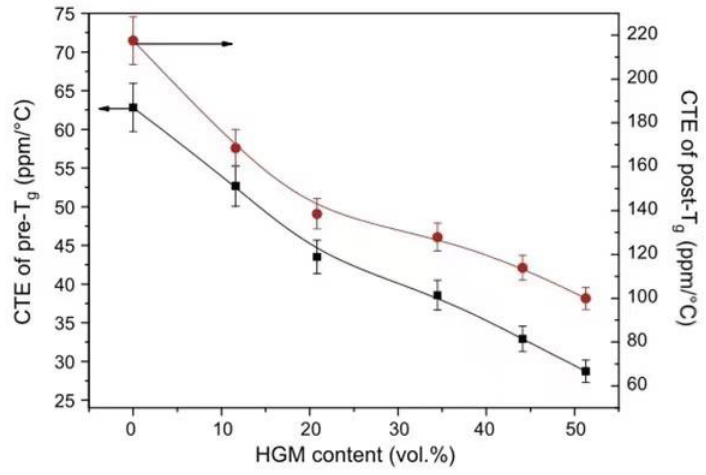
Figure 11. Thermal expansion coefficient of composites before and after the glass-transition temperature. Adapted with permission [62], Copyright 2008, Elsevier Ltd.